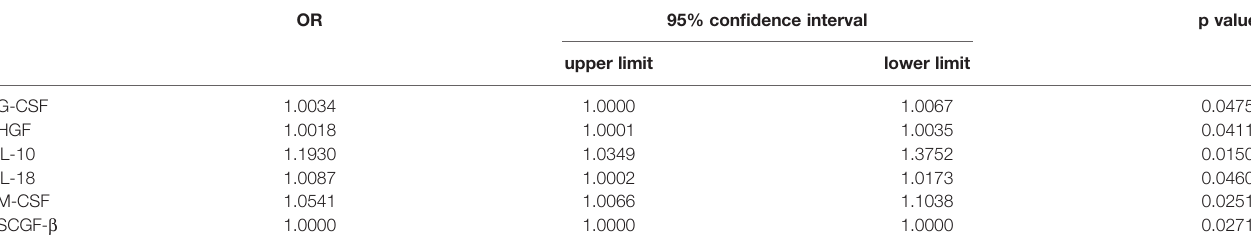
TABLE 3 | Results of univariate analyse identifying independent cytokine associated with the severity of COVID-19.